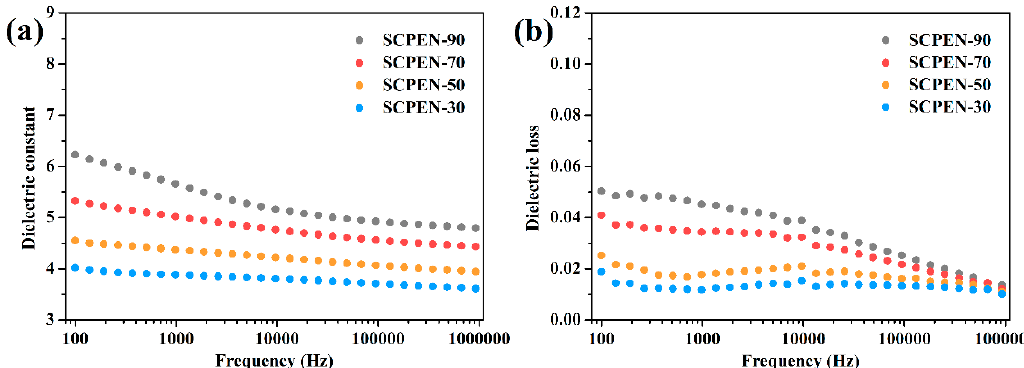
Figure 6. Frequency dependencies of ( a ) dielectric constant and ( b ) dielectric loss for SCPEN films.